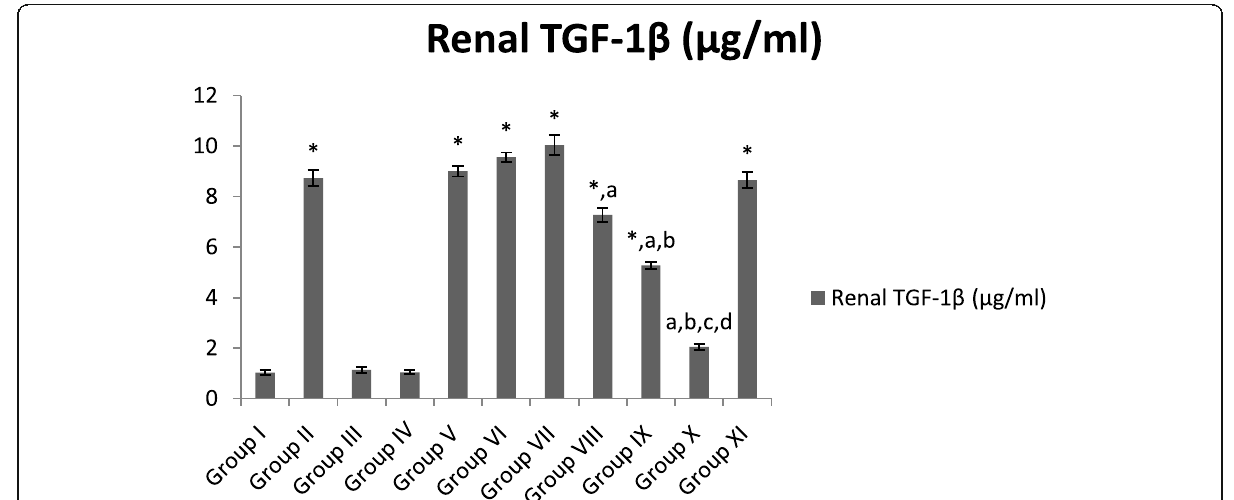
Fig. 8 Graph representing TGF- β levels ( μ g/ml). All values were represented as mean ± SEM. *= p < 0.001 versus group I (normal control); a = p < 0.001 versus group II (uninephrectomised diabetic control); b = p < 0.005 versus group V (uninephrectomised diabetic rats with oleamide (1mg/kg) treatment; c = p < 0.005 versus group VI (uninephrectomised diabetic rats with oleamide (2.5mg/kg) treatment); d = p < 0.005 versus group VI (uninephrectomised diabetic rats with oleomide (5 mg/kg)